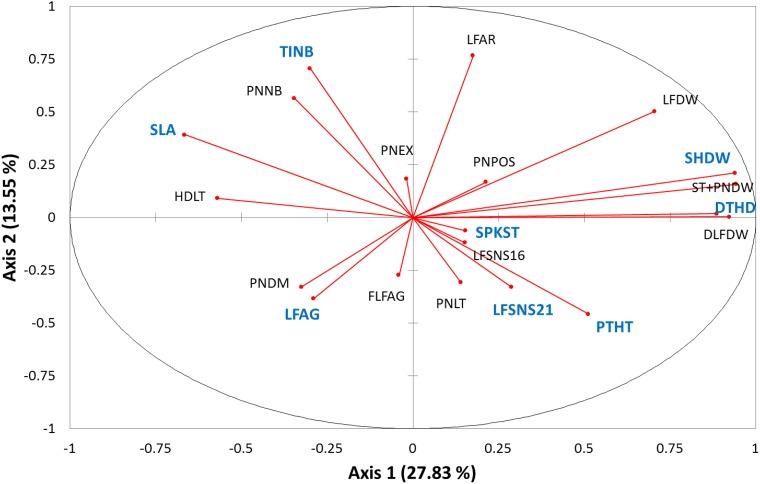
Projection of the contribution of the 20 phenotypic traits on the plan of the first two axes of a Principal Component Analysis.Traits subjected to three methods of GWAS are indicated in blue.